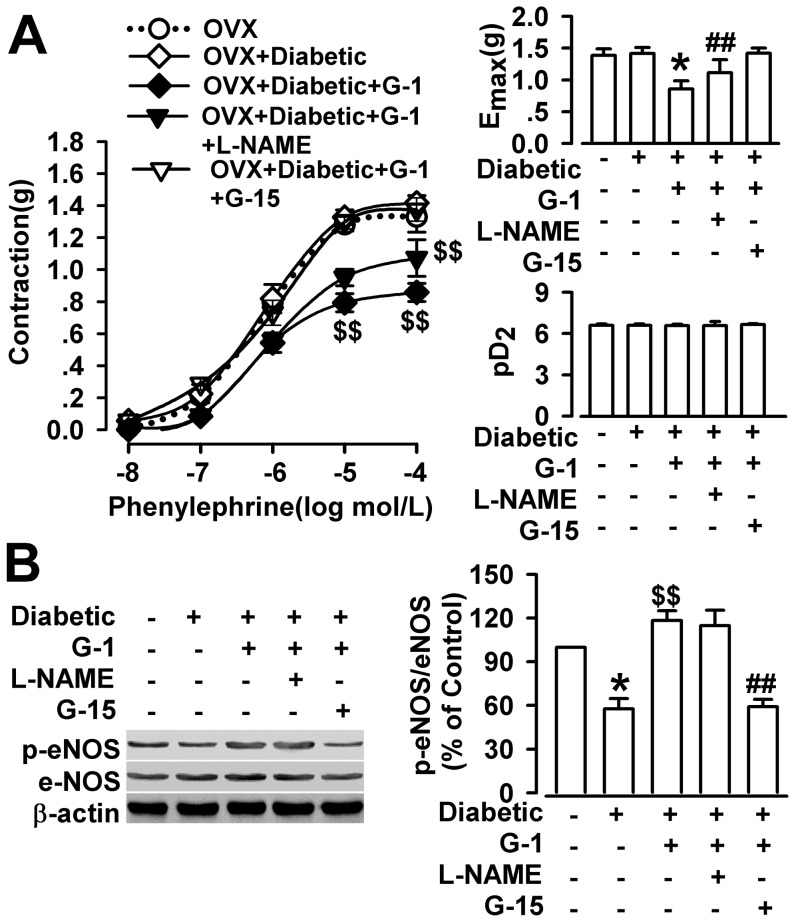
G1 pretreatment on the contraction response to PE in diabetic OVX rats.(A) There was no difference on contraction of thoracic aorta between OVX and diabetic OVX groups. G1 (3 µmol/L) treatment dilated the thoracic arteries in the presence of PE (1 mM) in diabetic OVX rats. L–NAME (100 µM) and G15 (1 µM) abolished the effect of G1 in the diabetic OVX rats as shown by the maximal response (Emax) to PE. The sensitivity of arteries to PE (pD2) did not change among groups. (B) The eNOS phosphorylation was significantly reduced in OVX diabetic group as compared with OVX group. G1 treatment increased the eNOS phosphorylation; whereas, G15 blocked the eNOS phosphorylation induced by G1. n = 6–12 rings from 4–6 rats.*
p<0.05 compared with OVX rats; ##
p<0.01 compared with diabetic OVX+G1 rats; $$
p<0.01 compared with diabetic OVX rats. Results are given as the mean ± SEM of three independent experiments.